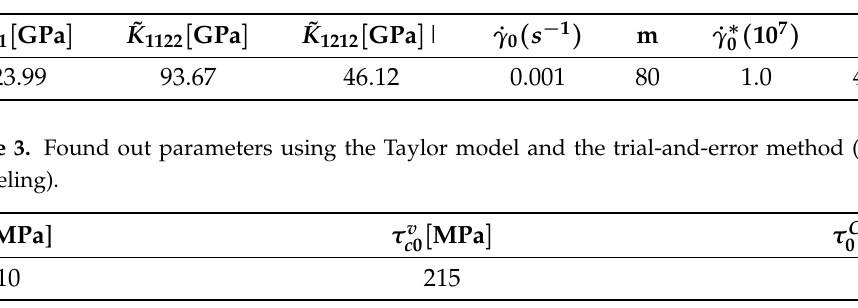
Table 2. A list of used input parameters for the Ag phase [38,48].